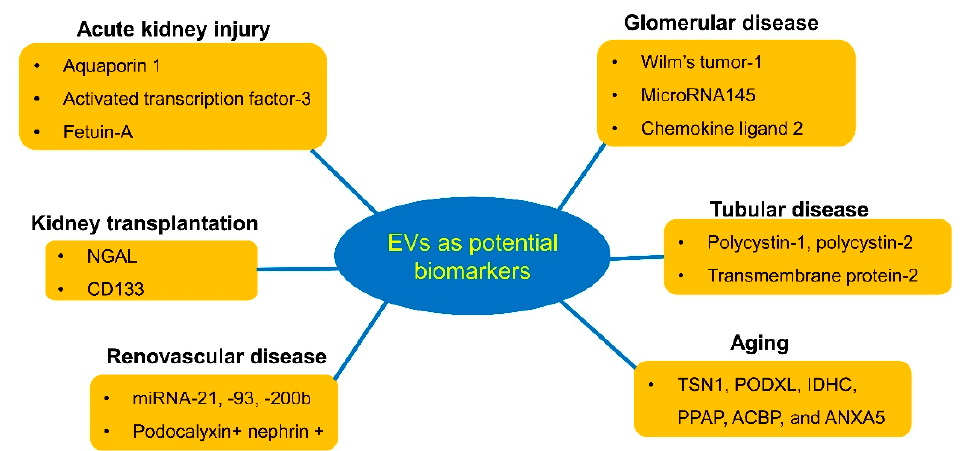
Figure 1. Potential biomarkers of urinary extracellular vesicles (EVs) in kidney diseases. Urinary EVs may augment the ability to diagnose and monitor renal conditions. Their most useful application may be predicting the clinical outcome of patients with kidney disease and guiding treatment decisions.